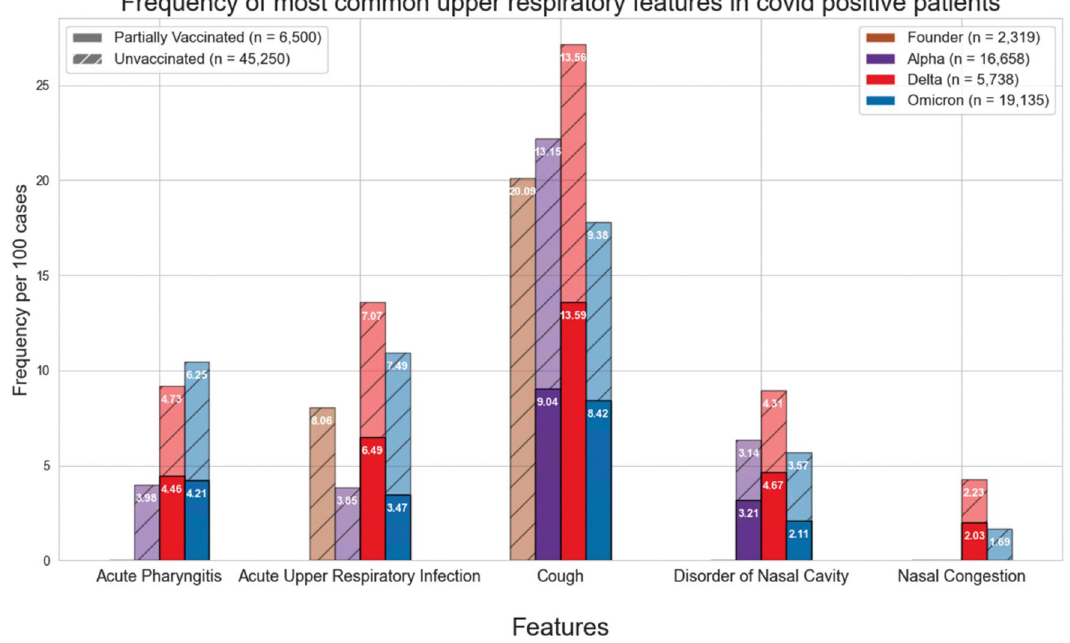
Figure 5. Comparison of frequency of most common upper respiratory features in COVID positive patients based on partially vaccinated or unvaccinated